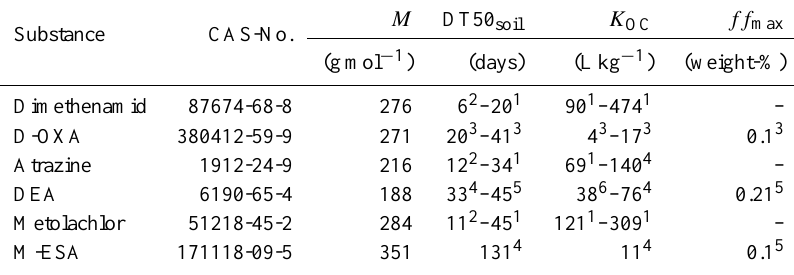
Table 1. Physico-chemical properties of studied pesticides and their TPs with molar mass M, degradation half-life in soil DT50 soil , organic carbon sorption coefficient K OC and maximum formation fraction ff max